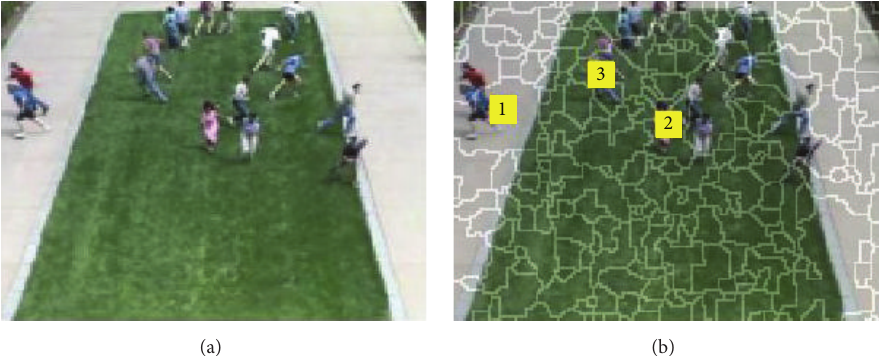
Figure 3: An example of spatiotemporal analogous patches. (a) The original image. (b) Partition patches overlap on the original